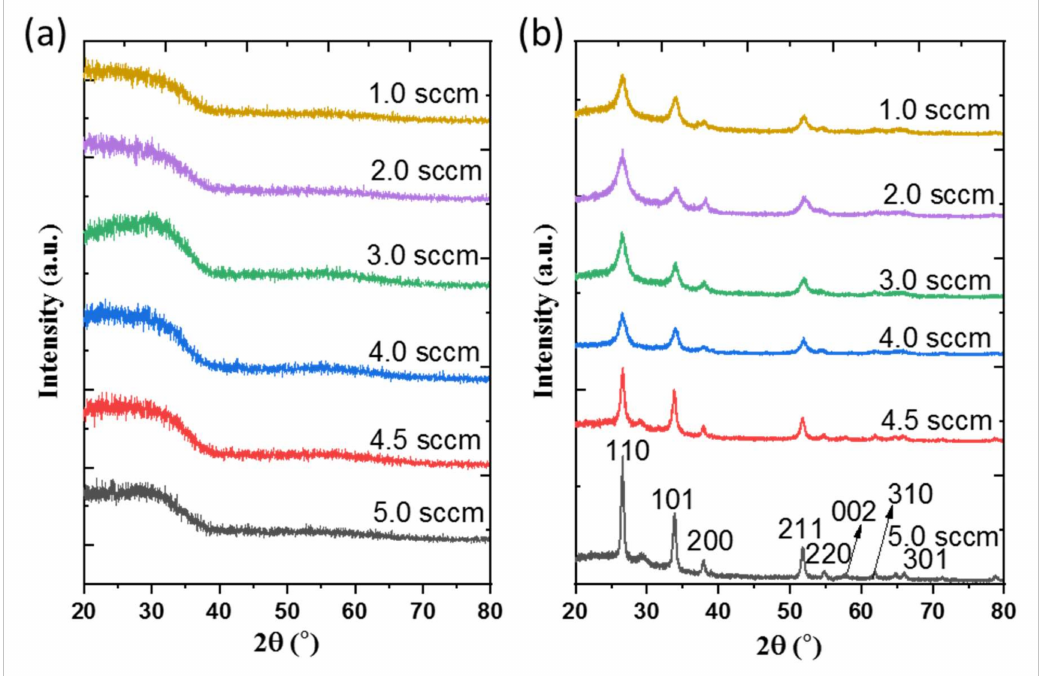
Figure 1. The XRD patterns of the as-deposited thin films ( a ) and after annealing at 450 ◦ C ( b ) under different oxygen flow